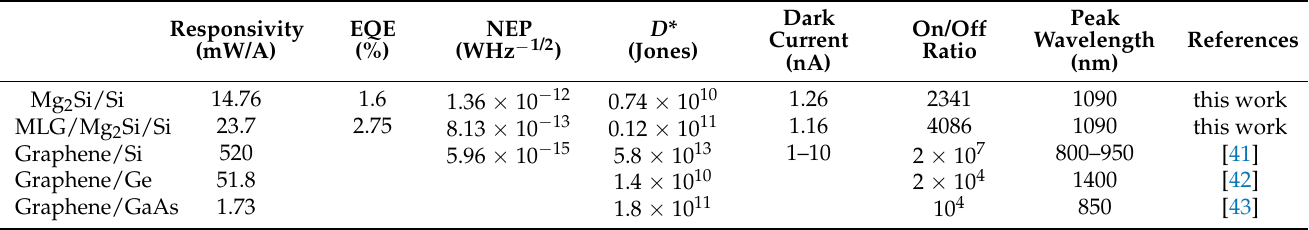
Table 1. The main detection properties of Mg 2 Si/Si and MLG/Mg 2 Si/Si heterojunction PDs and other